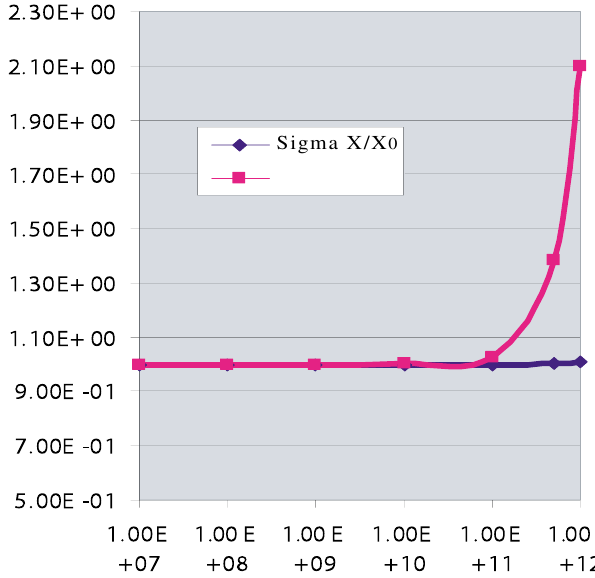
FIG. 54. (Color) Relative vertical (pink) and horizontal (blue) IP beam-size increase as a function of the electron cloud density, as simulated by CLOUD_MAD [55]; the horizontal axis is logarith- mic, and it extends from 10 7 to 10 12 m (cid:2) 3